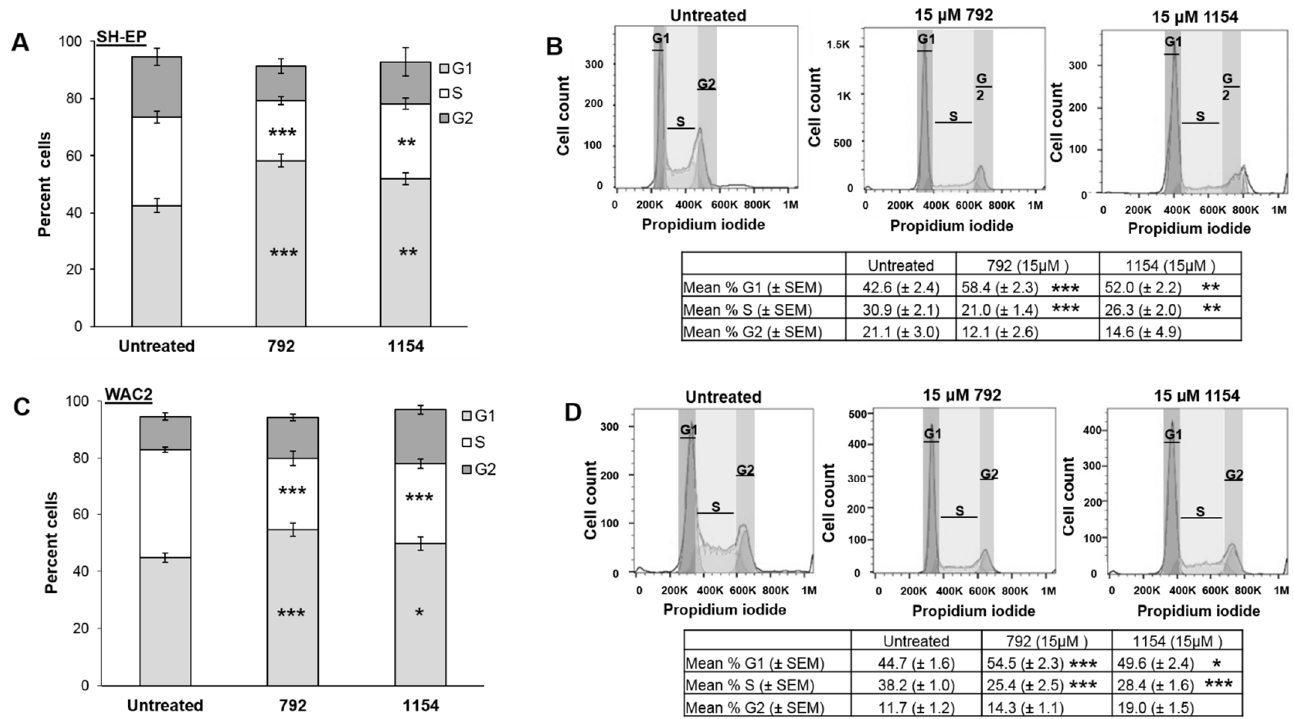
Figure 4. Compounds 792 or 1154 impaired progression through cell cycle. ( A ) Following treatment of either 792 or 1154 (0, 15 µ M), SH-EP cells had increased percent cells in G1 phase and decreased percent in S phase compared to untreated cells, indicating a lack of cell cycle progression. Data reported as percent cells ± SEM. ( B ) Representative histograms of cell cycle analysis of SH-EP cells treated with either 792 or 1154 (0, 15 µ M). Compiled data from at least three biologic replicates reporting the mean percent cells in phase ± SEM are presented in tabular form beneath the histograms. ( C ) WAC2 cells were treated with 792 or 1154 (0, 15 µ M) for 24 h. WAC2 cells had significantly increased percentage of cells in G1 phase as well as decreased percentage in S phase indicating failure to progress through cell cycle. Data reported as percent cells ± SEM. ( D ) Representative histograms of cell cycle analysis of WAC2 cells treated with either 792 or 1154 (0, 15 µ M). Compiled data from at least three biologic replicates reporting the mean percent phase ± SEM are presented in tabular form beneath the histograms. Experiments were repeated with at least three biologic replicates. Student’s t -test was used for comparisons. * p ≤ 0.05, ** p ≤ 0.01, *** p ≤ 0.001, compared to untreated (0 µ